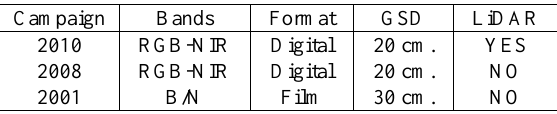
Table 1: Camera characteristics.